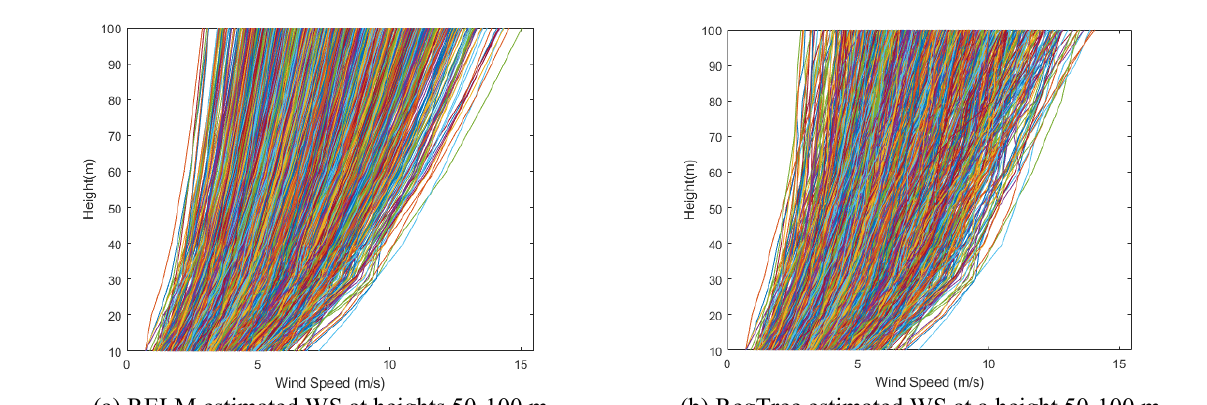
Figure 6. Performance of RELM, RegTree, and 1/7 power law on the estimation of WS at 50 m based on measurements between 10-40